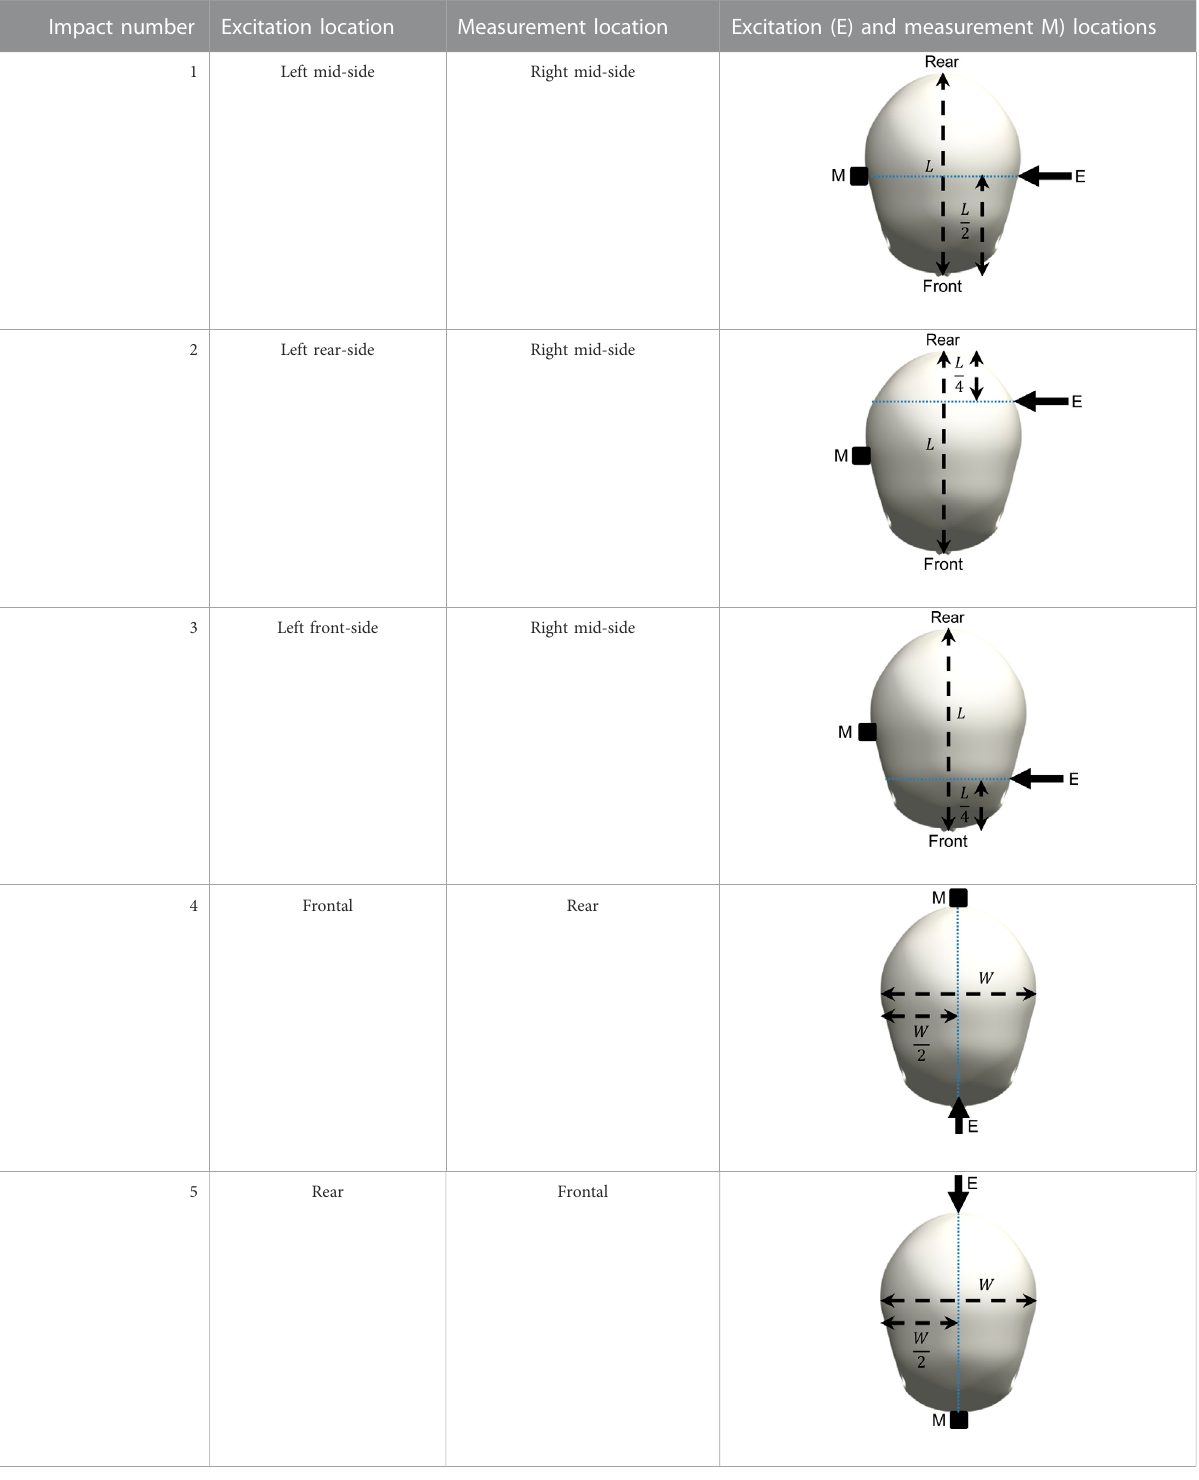
TABLE3De fi nition ofexcitation andmeasurement locations used toinvestigate the resonant frequency responseofthe surrogate headwhenconstrainedby bungee cords, the LUSN and the